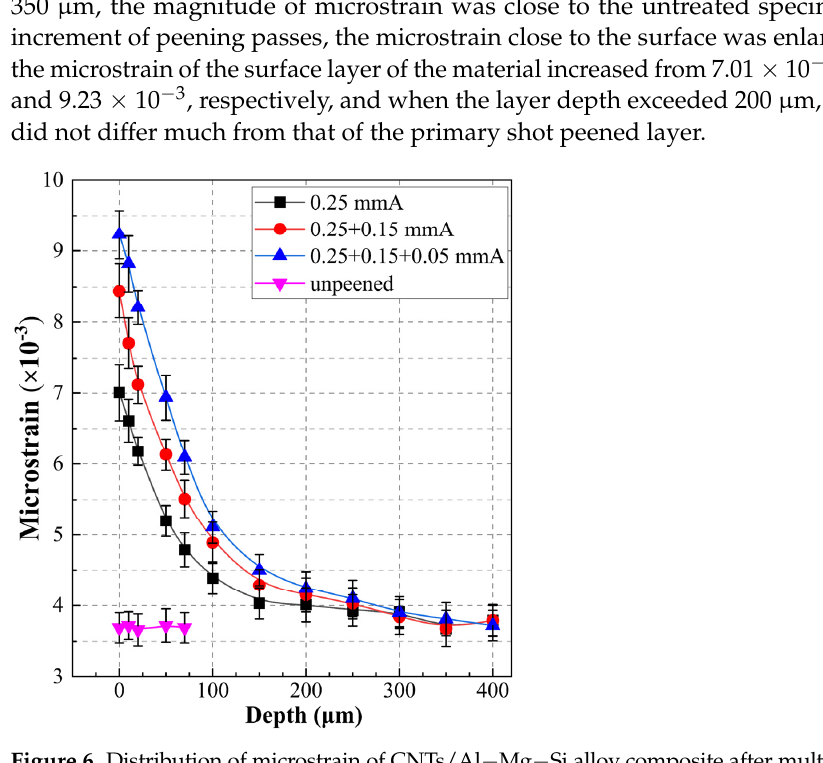
Figure 5. Domain size − depth distribution of CNTs/Al − Mg − Si alloy composite after multiple shot peening.